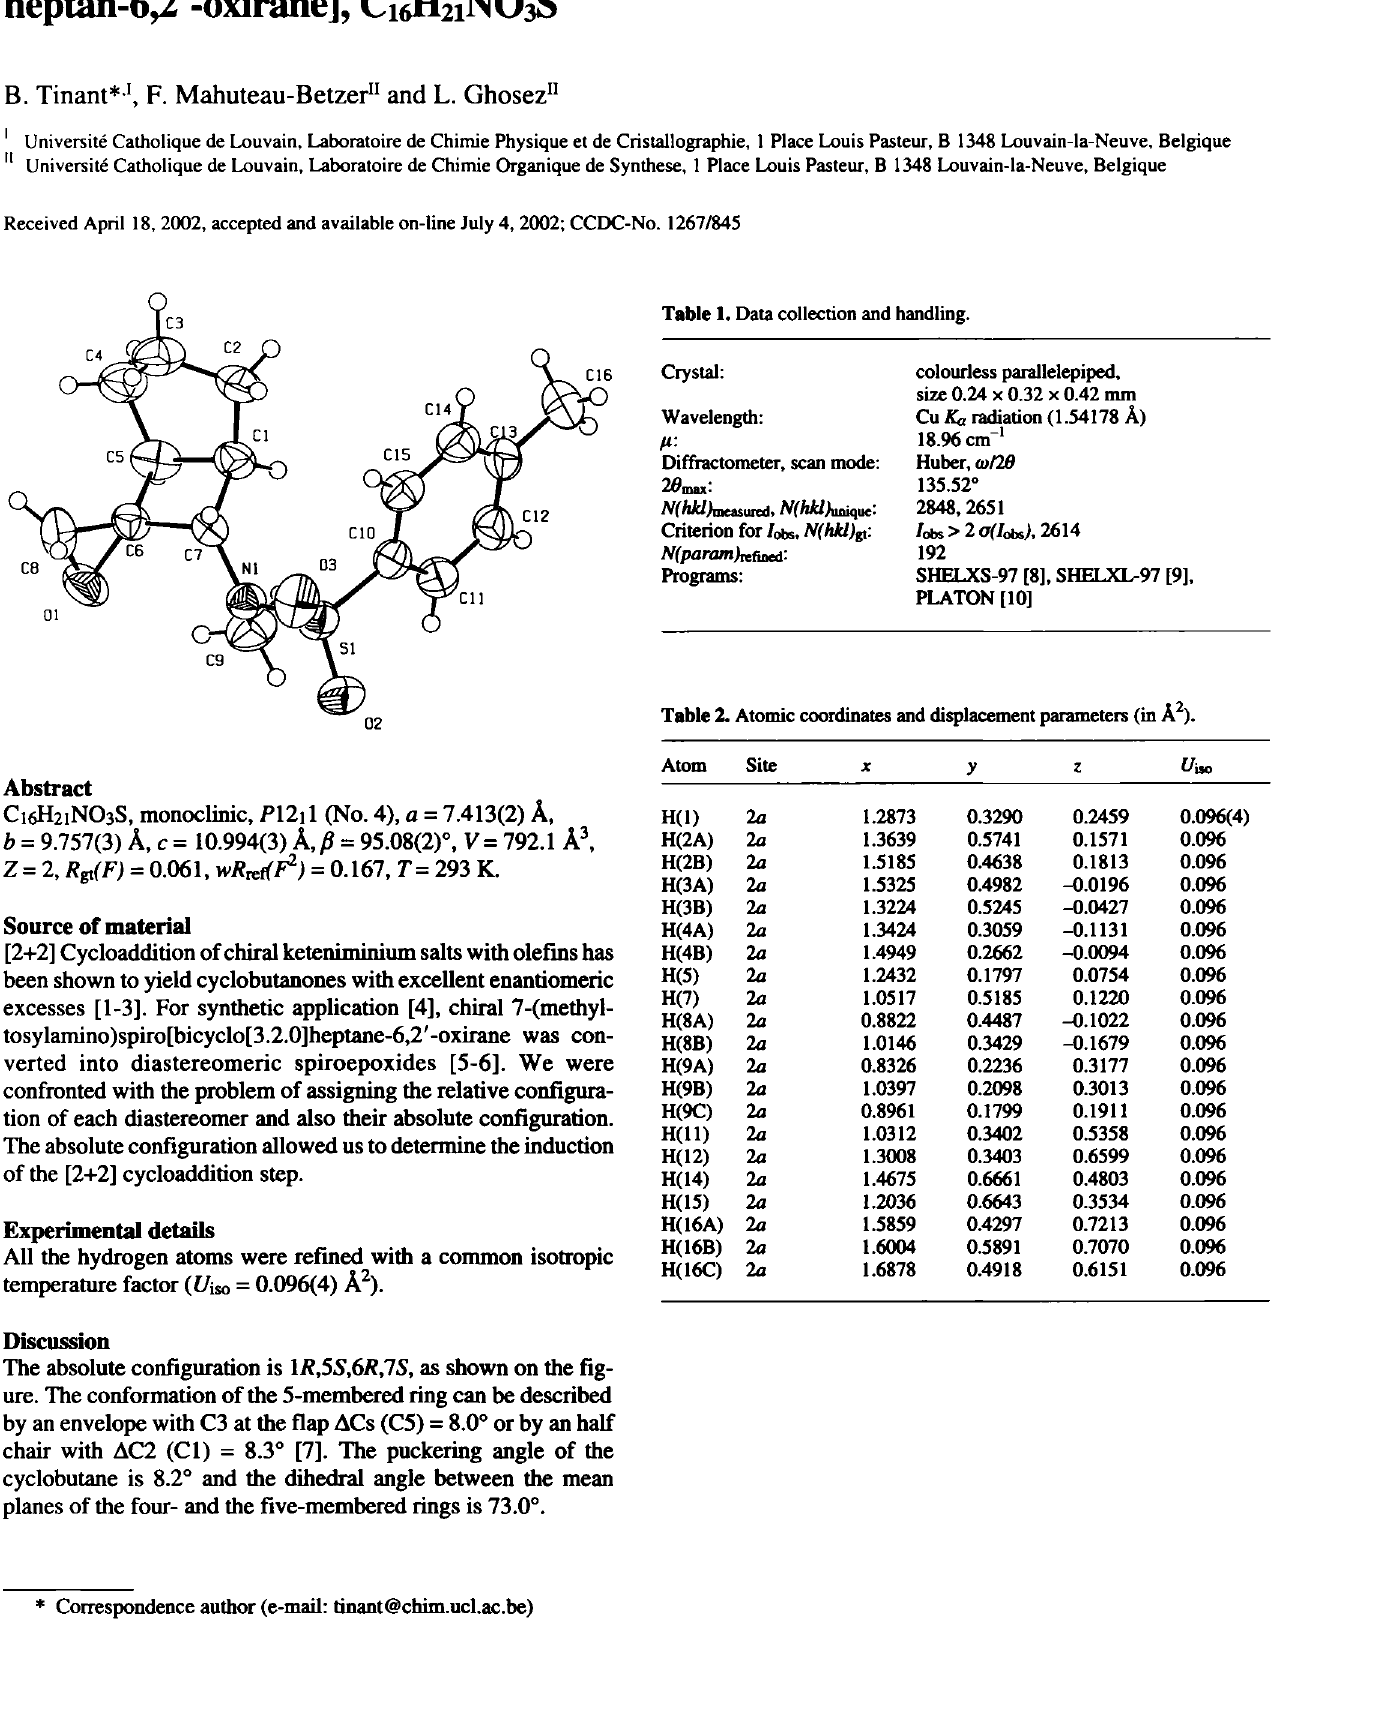
Table 1. Data collection and handling. Crystal: